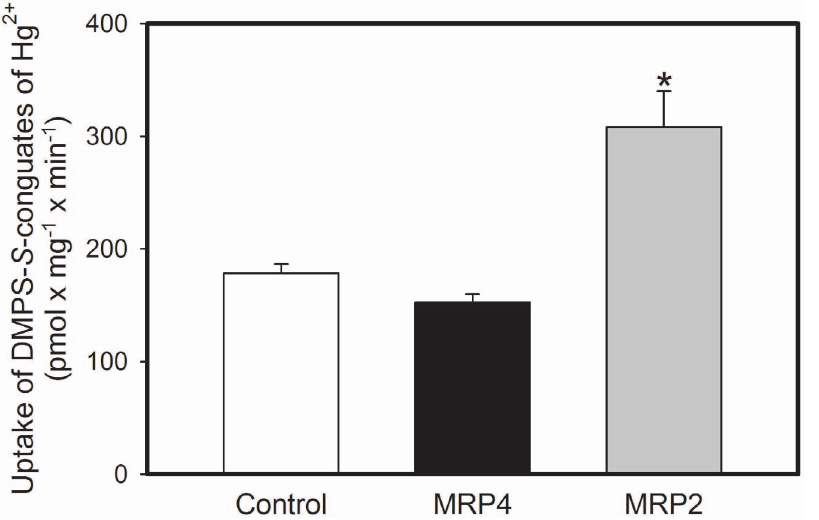
Figure 6. Transport of DMPS- S -conjugates of Hg 2 + into Inside-out Membrane Vesicles. Inside-out membrane vesicles expressing human MRP2, MRP4, or EYFP (control) were exposed to DMPS- S -conjugates of HgCl 2 for 30 s at 37 u C. Data represent mean 6 SE of four replicates. + , significantly different from mean of control vesicles (p , 0.05).